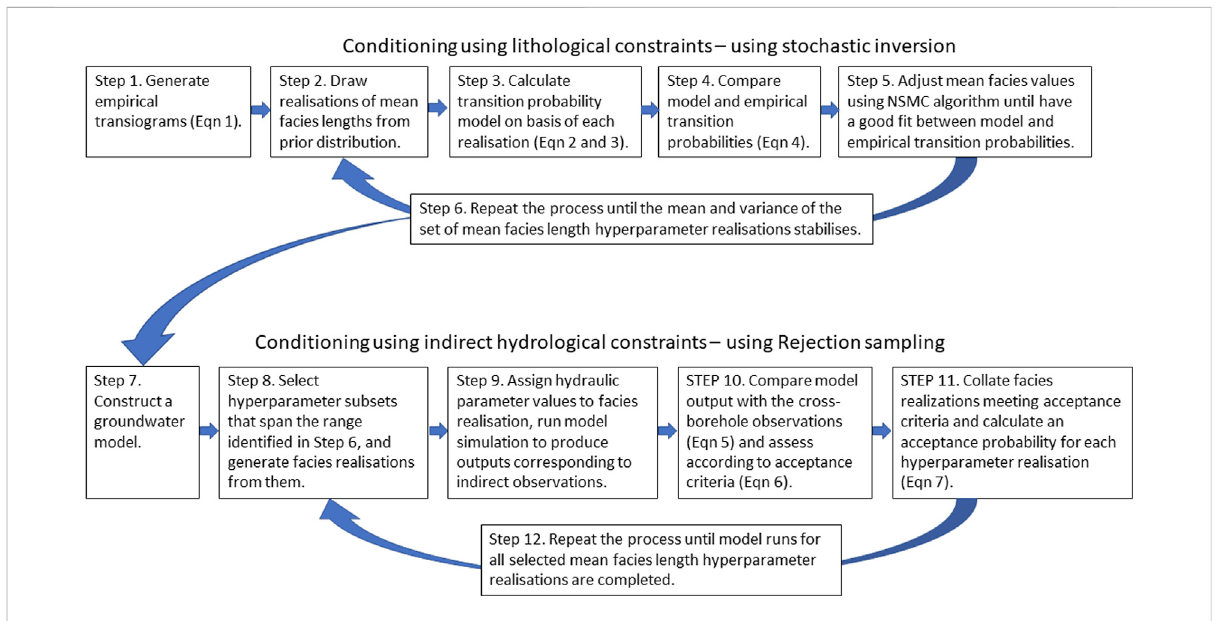
FIGURE 3 Flow chart showing the steps involved in the sequential Monte Carlo modelling